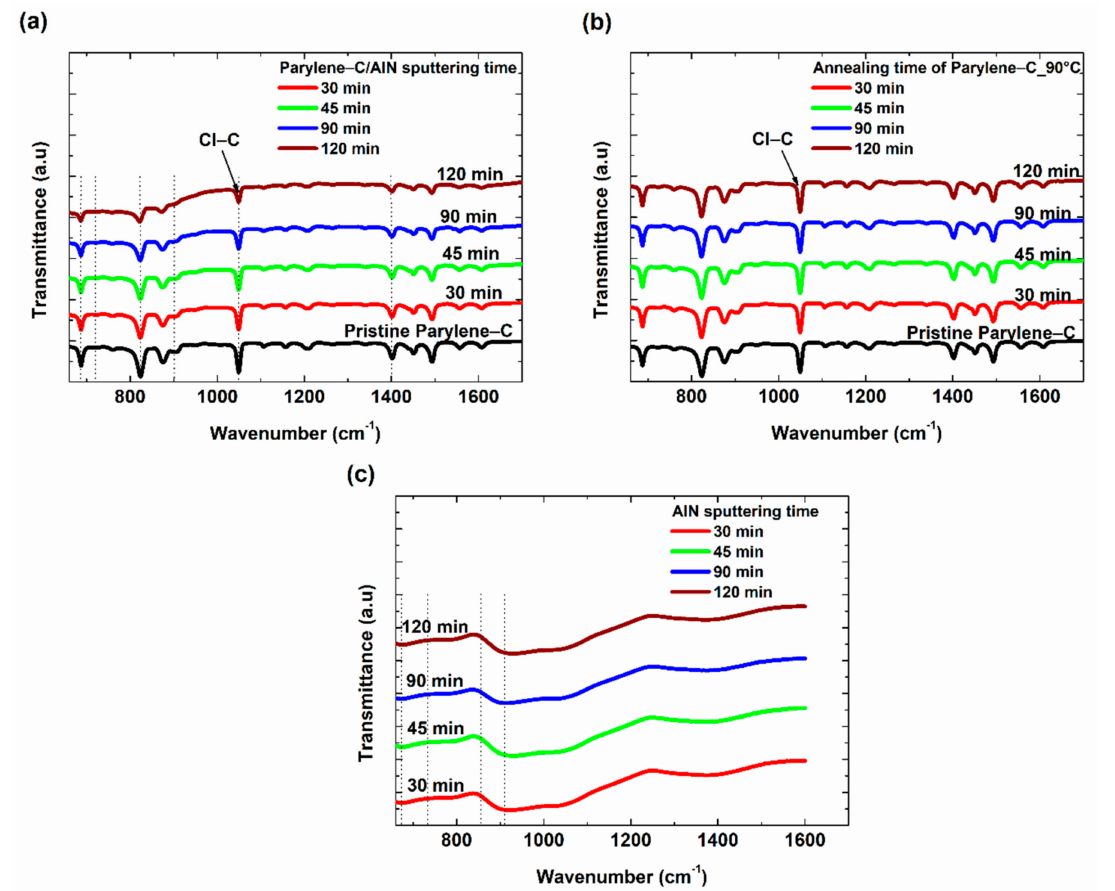
Figure 3. FTIR spectra. ( a ) Pristine parylene-C and parylene-C/AlN samples. ( b ) 90 ◦ C Annealed parylene-C. ( c ) AlN samples, with respect to sputtering